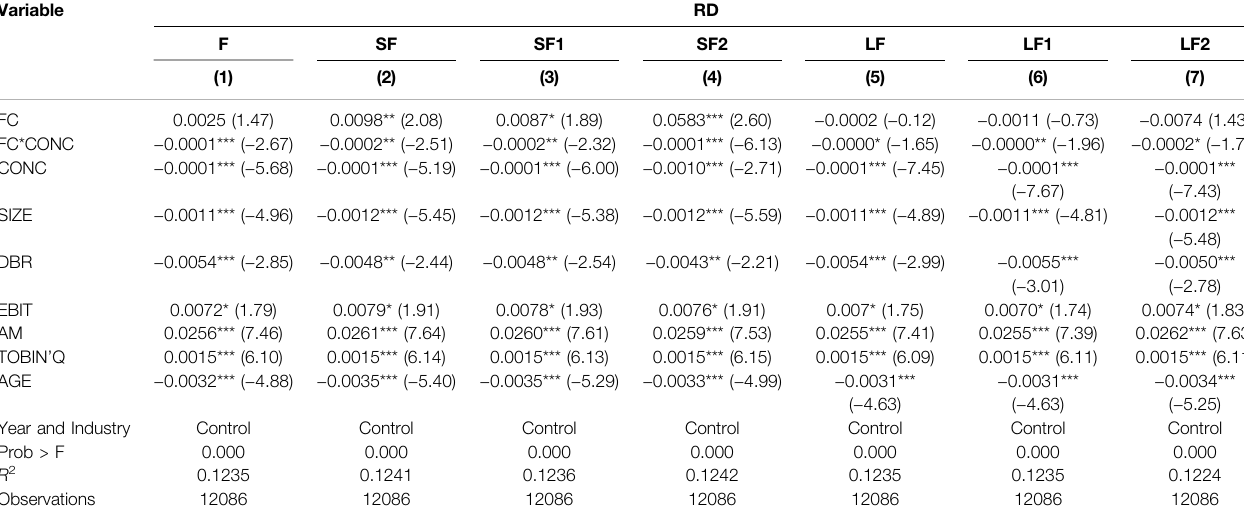
TABLE 6 | Regression results of the moderating effect of entity concentration on the relationship between fi nancialization and fi rm innovation. Variable